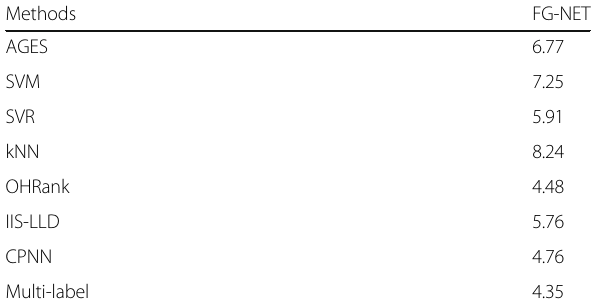
Table 2 MAE results of FG-NET dataset